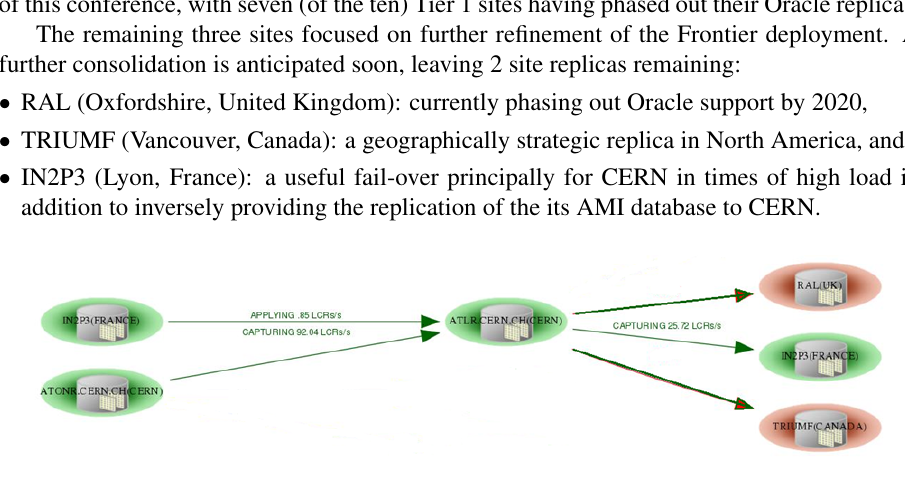
Figure 3. A snapshot of the ATLAS Database replication between Oracle RACs in 2019. The left hand side is identical to that in Figure 1 (2009 deployment). The needs of global event processing tasks are now served by the CERN central o ffl ine database and 3 ATLAS Tier 1 database